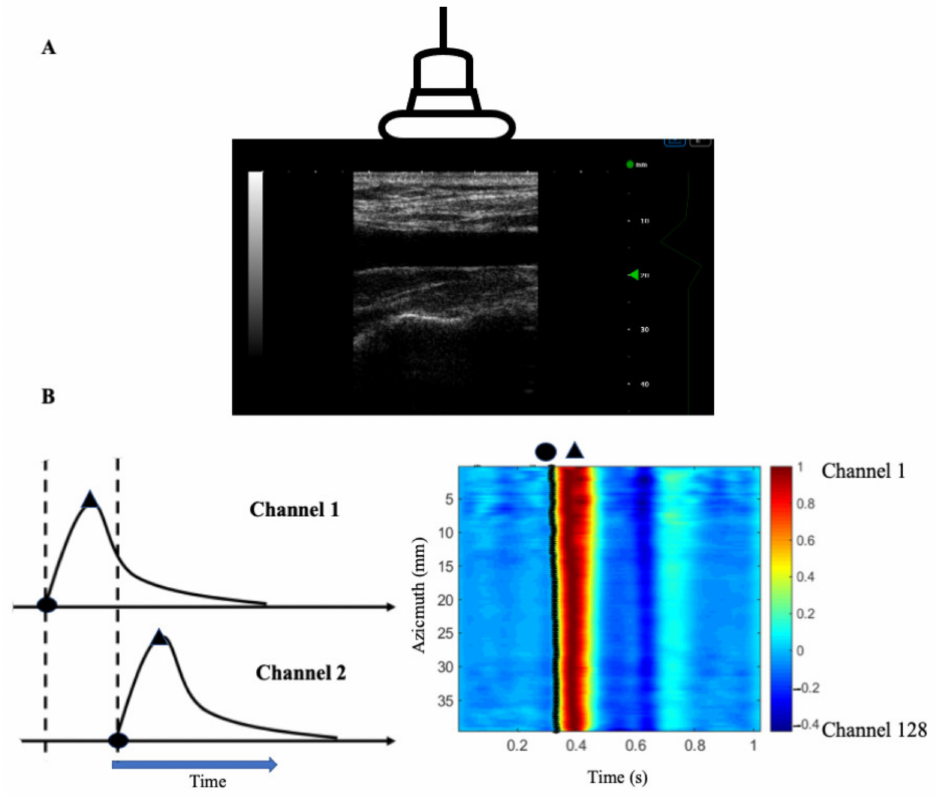
Figure 2. ( A ) B-mode images of common carotid artery obtained by the ultrafast ultrasound machine; ( B ) the left panel illustrates artery diameter change obtained from each channel (filled circle = diastole; triangle = systole). The right panel represents the linear regression after receiving signals from 128 channels. Red represents movements toward the probe. Blue represents movements away from the probe. Color brightness represents speeds of movements, where the brightest red line indicates the fastest pulse wave (systole). The reciprocals of symbol line slopes represent uf PWV-dia (filled circle) and uf PWV-sys (triangle),